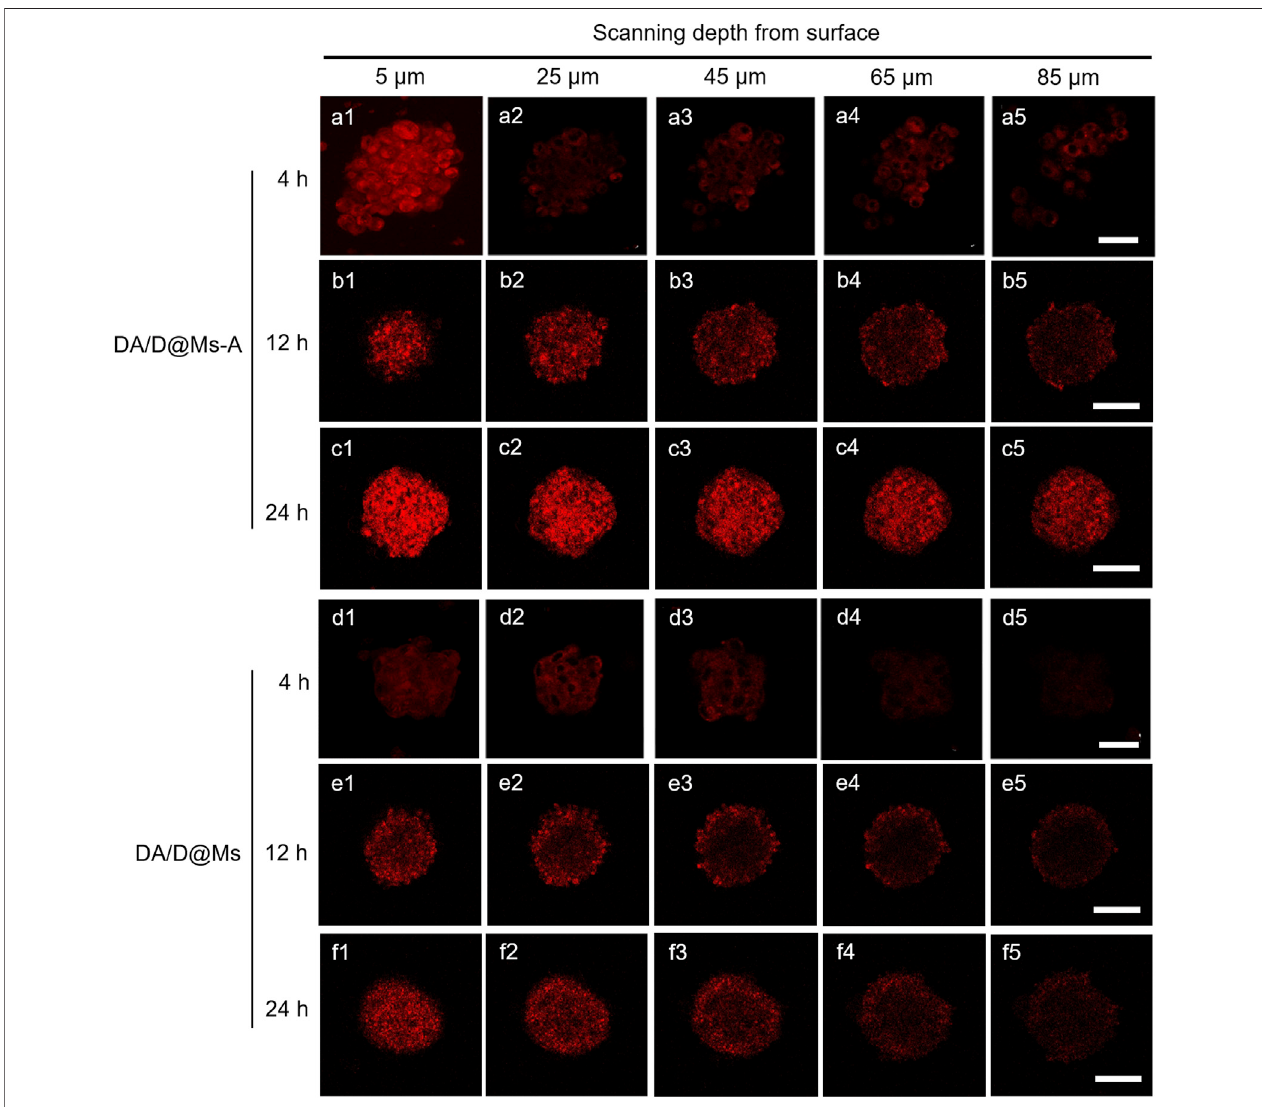
FIGURE 4 | CLSM images showing in vitro penetration of DA/D@Ms-A and DA/D@Ms in Panc-1 multicellular spheroids. The spheroids were incubated with 0.01 mg/ml DA/D@Ms-A or DA/D@Ms for 4, 12, and 24 h, respectively, and measured by CLSM Z-stack scanning. The surface of the spheroids was de fi ned as 0 μ m. Excitation wavelength = 488 nm, scale bar = 50 μ